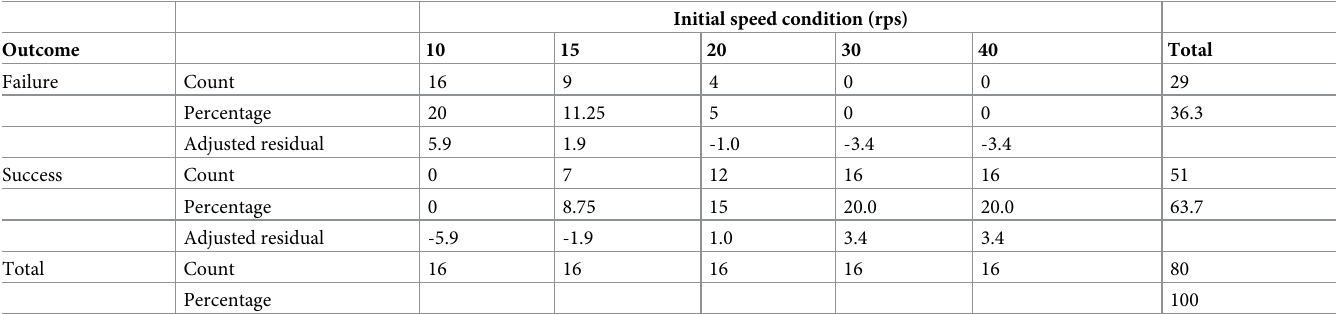
Table 1. Cross tabulation of the outcome and the initial speed